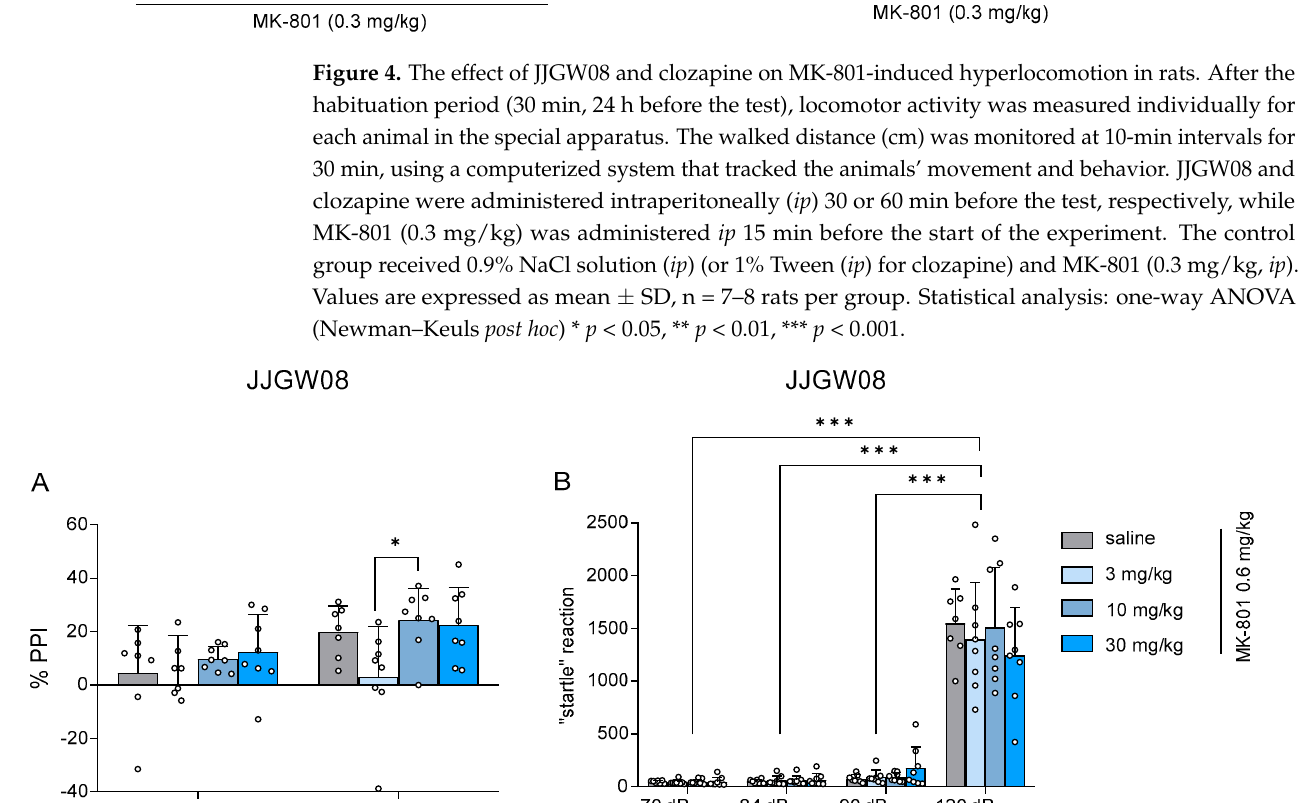
Figure 5. The influence of JJGW08 on startle response inhibition (Panel ( A )) and changes in startle response (Panel ( B )) in prepulse inhibition test after MK-801 administration in rats. The test was conducted in the soundproof apparatus, and the startle response amplitude was recorded. The experimental session (after a 5-min habituation period) had strictly defined parameters (prepuls-and- pulse trials: 84/120–prepuls 84 dB (20 ms), pulse 120 dB (40 ms); 90/120–prepuls 90 dB (20 ms), pulse 120 dB (40 ms), sham stimulus (70 dB, 40 ms)), and the startle intensity for each stimulus used in the session was measured. JJGW08 was administered ip 30 min before the test, while MK-801 (0.6 mg/kg) was administered ip 15 min before the start of the experiment. The control group received 0.9% NaCl solution ( ip ) and MK-801 (0.6 mg/kg, ip ). Values are expressed as mean ± SD, n = 7–8 rats per group. Statistical analysis: two-way ANOVA with repeated measures (Bonferroni post hoc ), * p < 0.05, *** p < 0.001, %PPI—a percentage of prepulse inhibition. The magnitude of the startle response is presented in arbitrary manufacturer’s units.